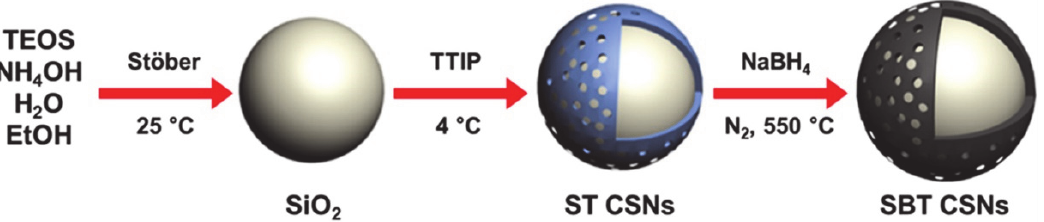
Figure 3. Schematic illustration for synthesis method of SiO 2 nanoparticles, ST CSNs, and SBT CSNs via sequential Stöber, sol-gel, and NaBH 4 reduction methods, respectively.